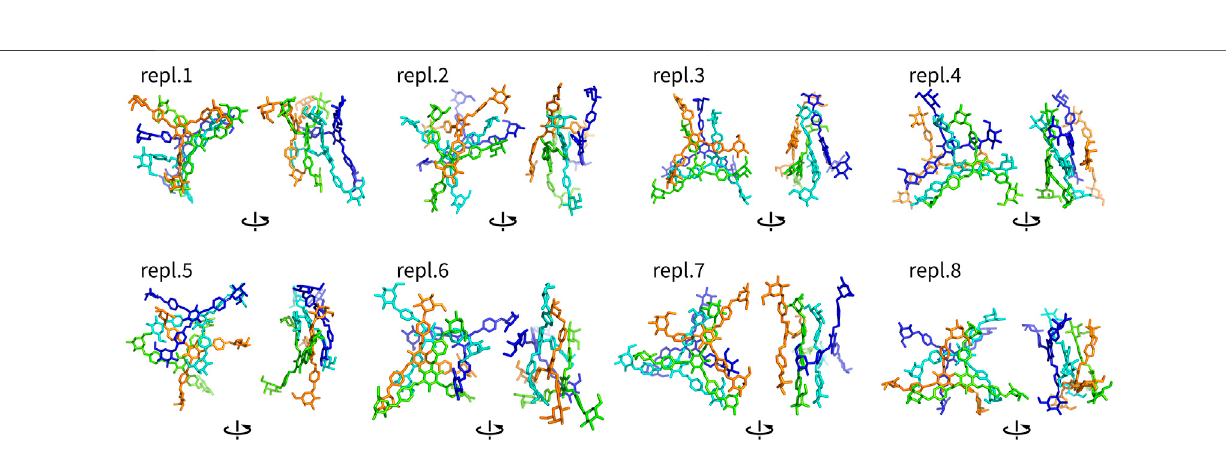
Frontiers in Molecular Biosciences |